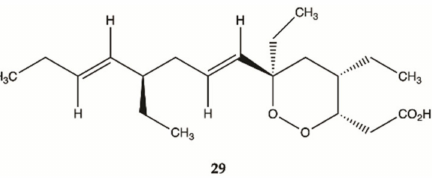
Figure 13. Plakortide 29 isolated from Marine Sponge Plakortis halichondroides [52].